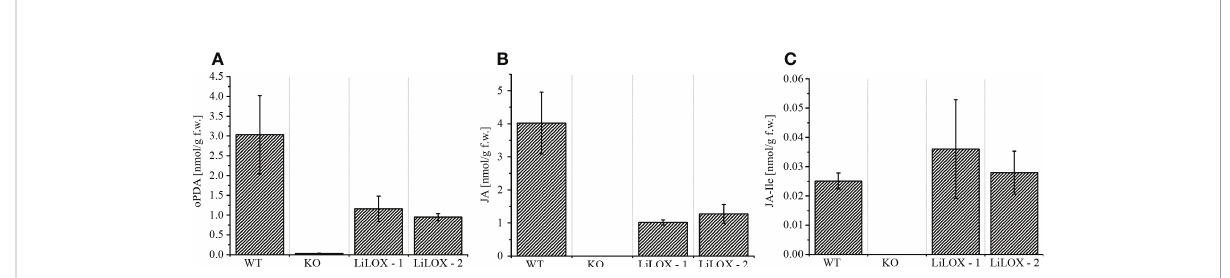
FIGURE 8 JA pathway metabolites in A. thaliana 13-lox KO. WT: A. thaliana Col-0. KO: A. thaliana Col-0 from which all 13-LOX ( AtLOX2 , AtLOX3 , AtLOX4 and AtLOX6 ) were knocked out. LiLOX-1 and LiLOX-2 are two lines of A. thaliana 13S-lox KO, complemented with LiLOX under the 35S promotor. Two hours after wounding leaves were harvested and extracted. Phytohormone levels were measured by LC-MS/MS. Error bars represent the standard deviation of three measurements. All three measurements were performed from three different plants grown in parallel. (A) oPDA. (B) JA. (C)